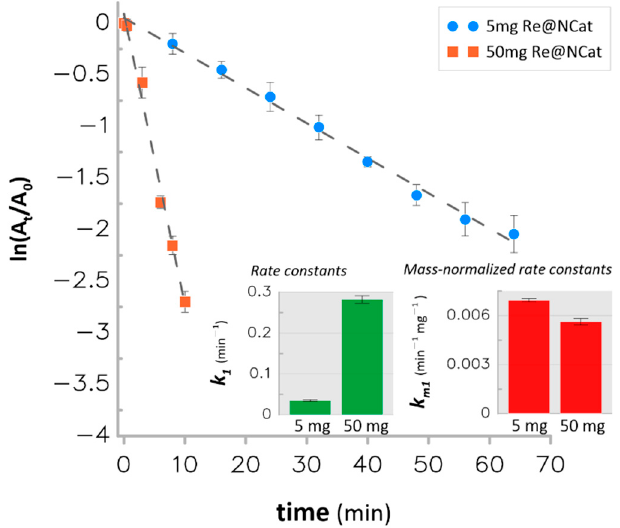
Figure 5. First-order kinetics plots for the catalytic hydrogenation of 4-NP using 5 and 50 mg of the